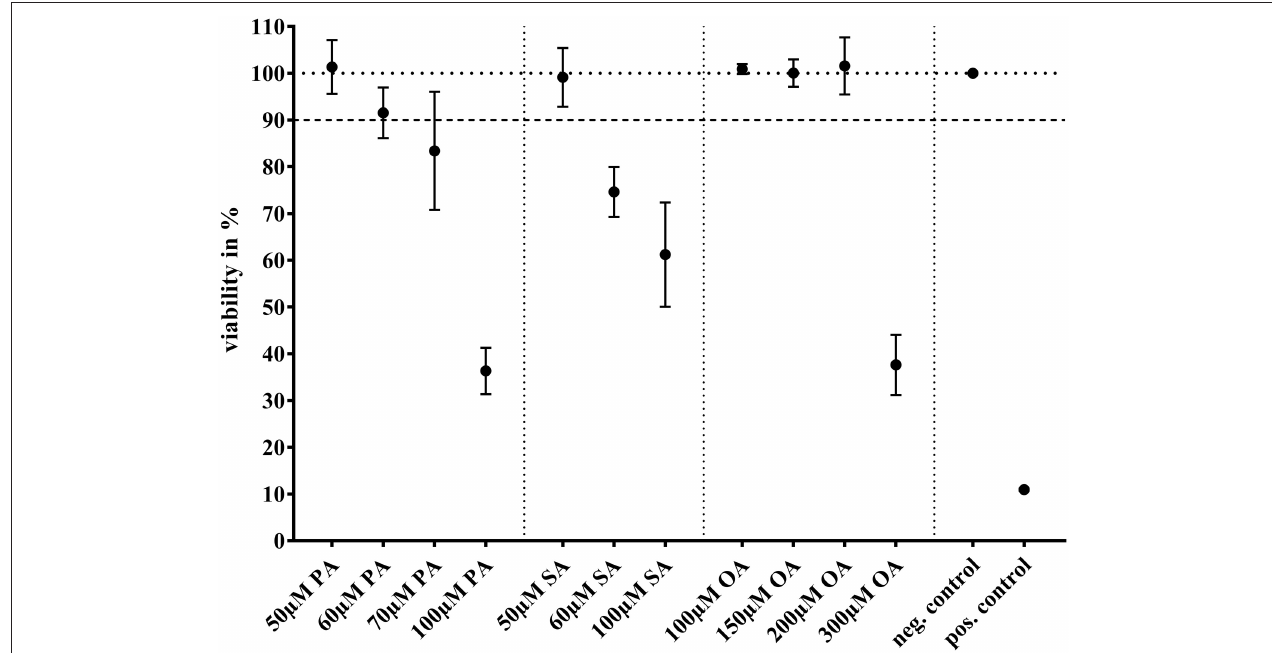
FIGURE 1 | MTT assay showing viability (in %) after treatment with different concentrations of palmitic acid (PA; N = 3; n = 6), stearic acid (SA; N = 3; n = 3), or oleic acid (OA; N = 3; n = 3). For negative control, cells were treated with base medium + 0.1 % ethanol and for positive control with Triton X (5 mg/ml in PBS). A 90% viability was accepted for further experiments. Dots represent arithmetic mean and whiskers standard